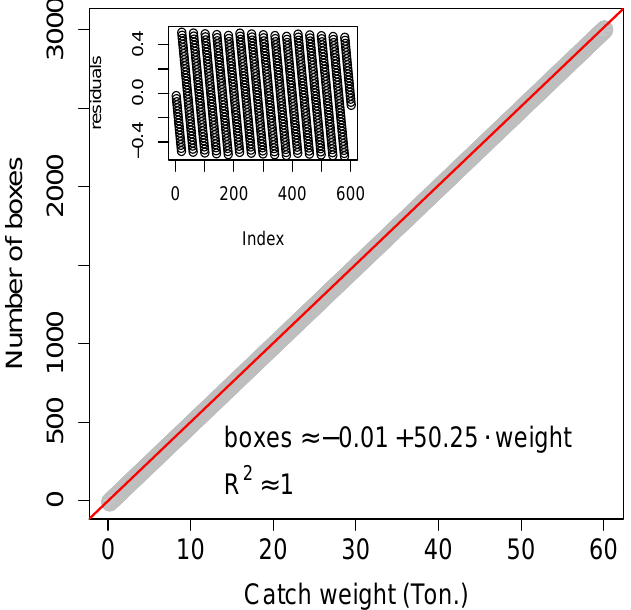
Figure 3. Unloaded catch ratio (ton) and number of boxes. Source: Chilean Undersecretary of Fisheries and Aquaculture (SUBPESCA, 2019b).